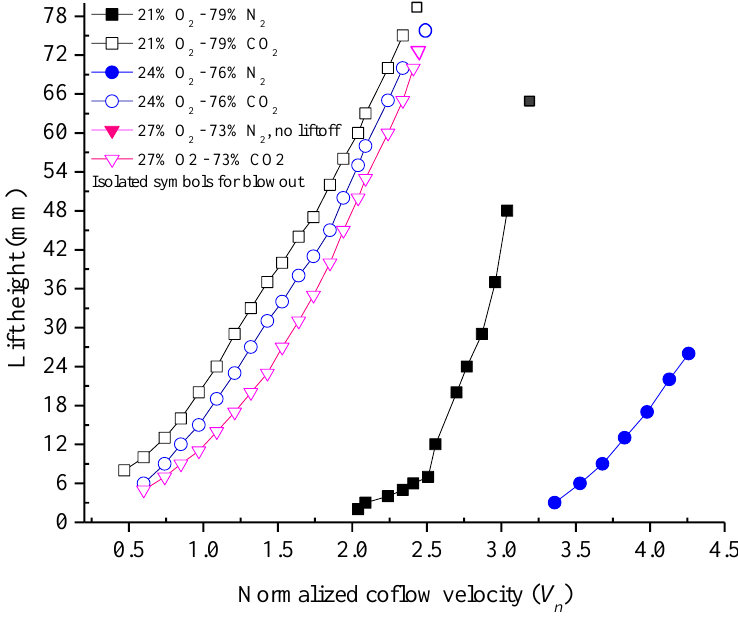
Figure 4. Flame lift height versus normalized coaxial-flow velocity.